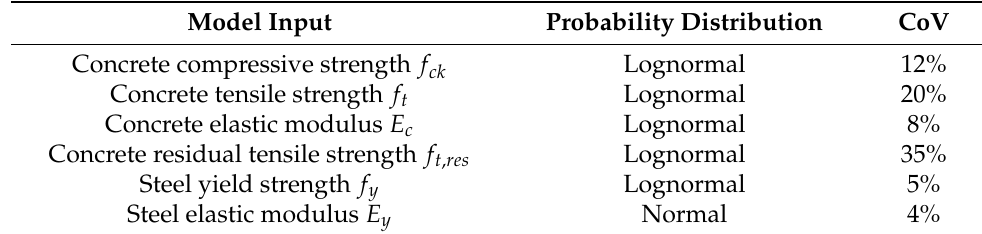
Table 1. Probability distribution of material properties.